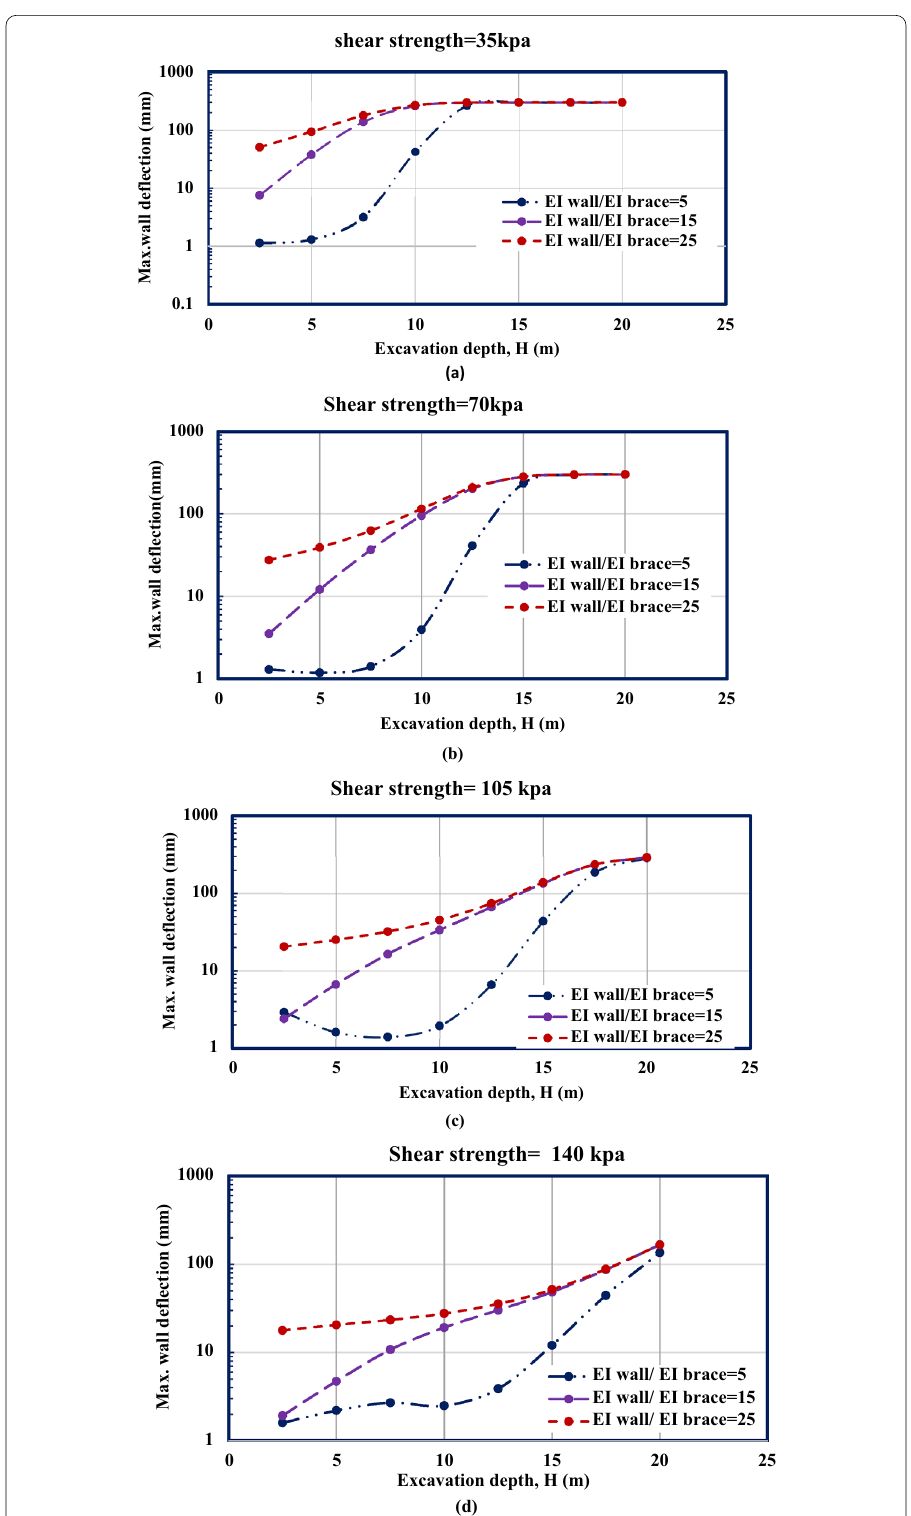
Fig. 11 Maximum wall deflections predicted by the ANN versus variation excavation depth, for L/B K o 0.53, h s 2.5 = =